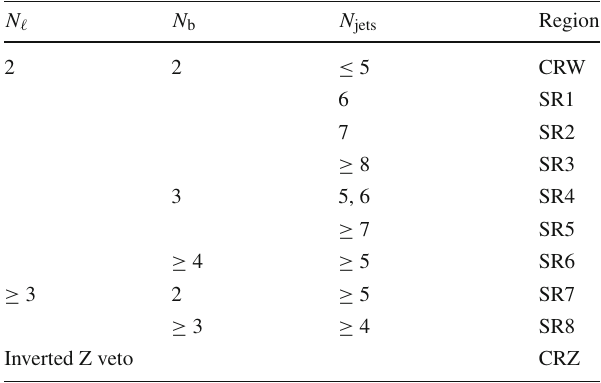
Table 2 Definitions of the eight SRs and the two control regions for ttW (CRW) and ttZ